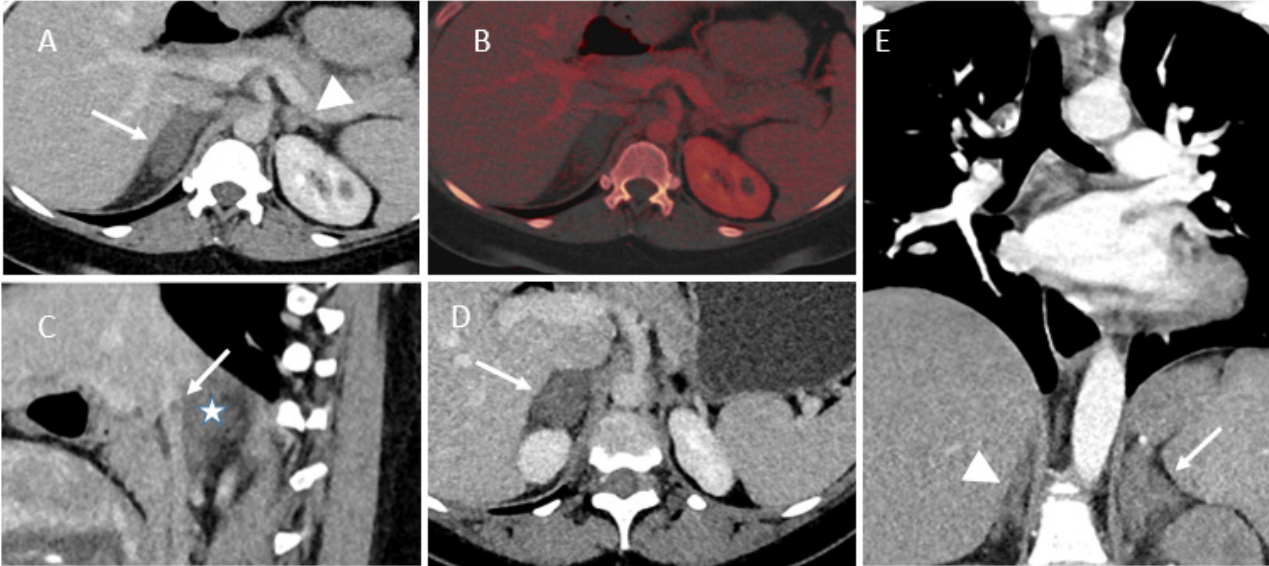
Figure 2. Contrast-enhanced CT findings of NHAI. ( A – C ) Patient 2. A: enhanced dual source CT showing an enlarged unenhanced right adrenal gland (arrow). Normal appearance of the contralateral adrenal gland (arrowhead). ( B ) Fusion of virtual non-contrast CT and iodine overlay image, demonstrating more easily the non-enhanced pattern. ( C ) Sagittal view of contrast-enhanced CT, showing the tail of the adrenal vein thrombus extending into the inferior vena cava (arrow) and the enlarged unenhanced right adrenal gland (star). ( D ) Patient 4, enlargement of the right adrenal gland. ( E ) Patient 5, CT pulmonary angiogram showing enlargement of the left adrenal gland and infiltration of the adjacent fat. Normal appearance of the contralateral adrenal gland (arrowhead).